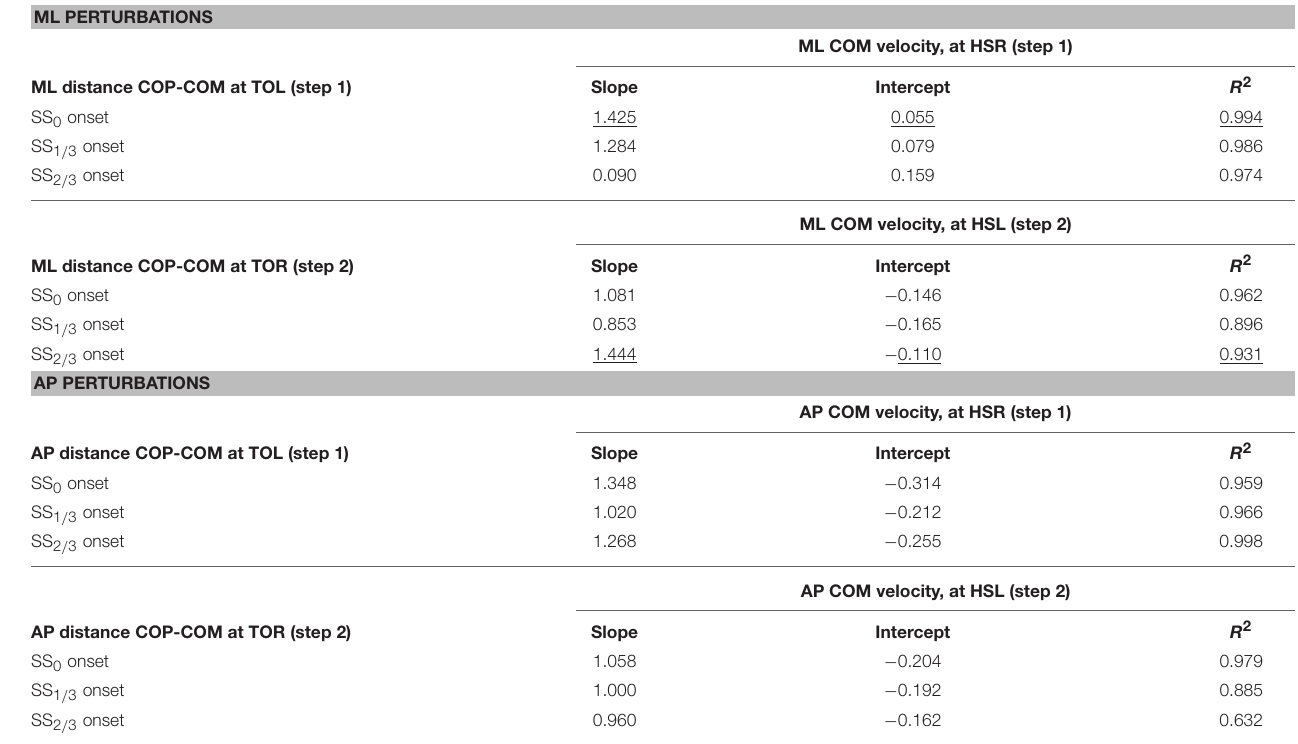
TABLE 1 | Slope, intercept, and coefficient of determination of the linear least squares (LLSQ) fit made to the subject-average data at specific instances of the gait cycle after the perturbation. ML